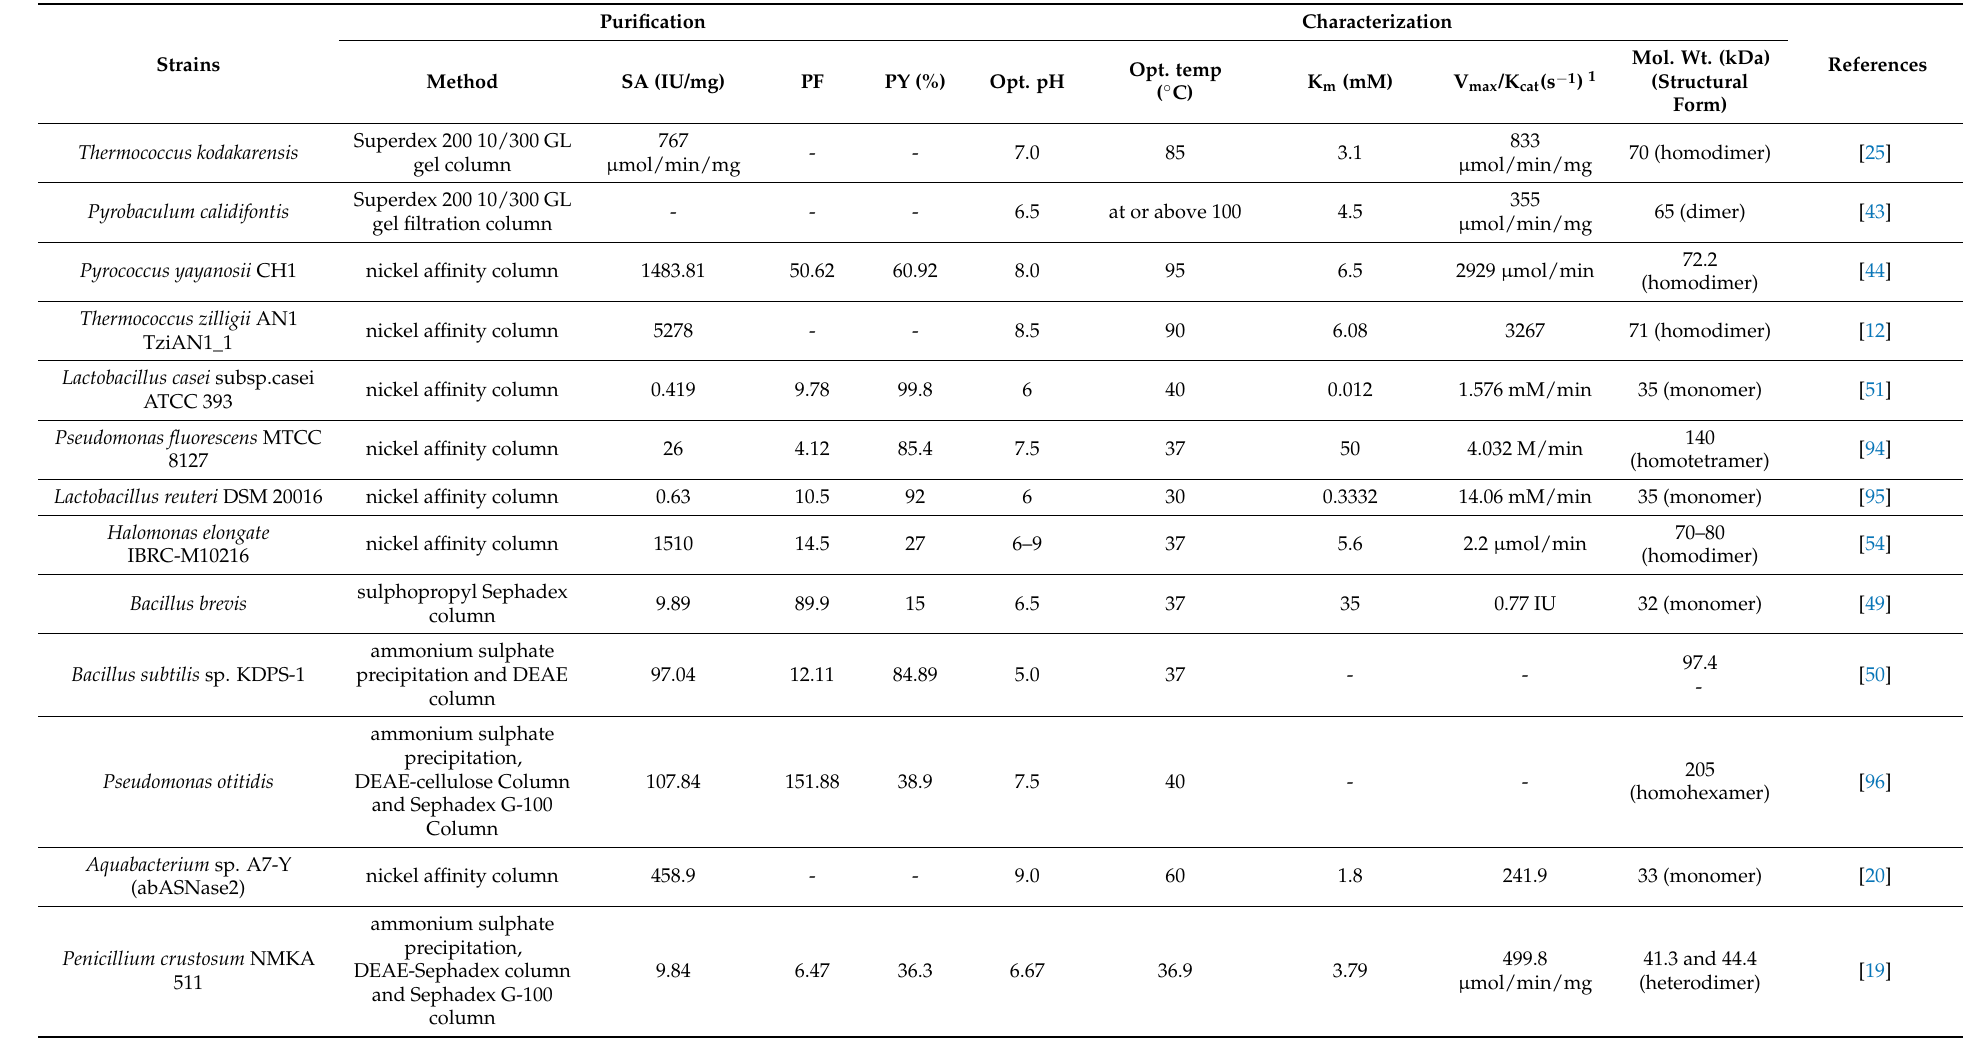
Table 2. Purification methods and biochemical characteristic of L-asparaginase produced by